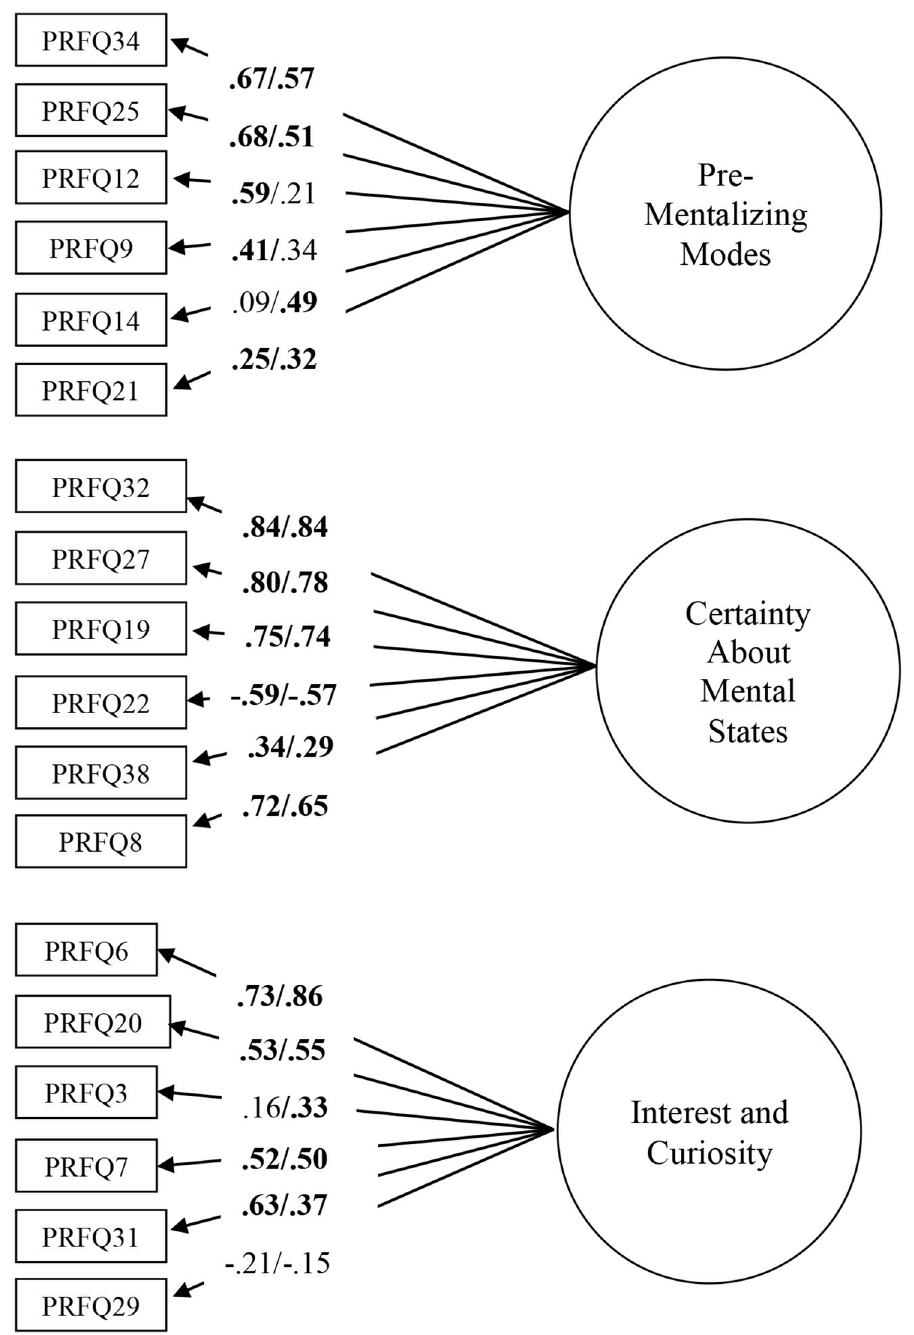
Fig 2. Multigroup CFA with factor loadings for fathers (left) and mothers (right) in Study 2. Residuals and correlations betweenresidualsare omitted for clarity of presentation.Rectanglesindicatemeasured variablesand circles represent latent constructs. Standardized maximum likelihood parametersare used. Bold estimates are statistically significant.